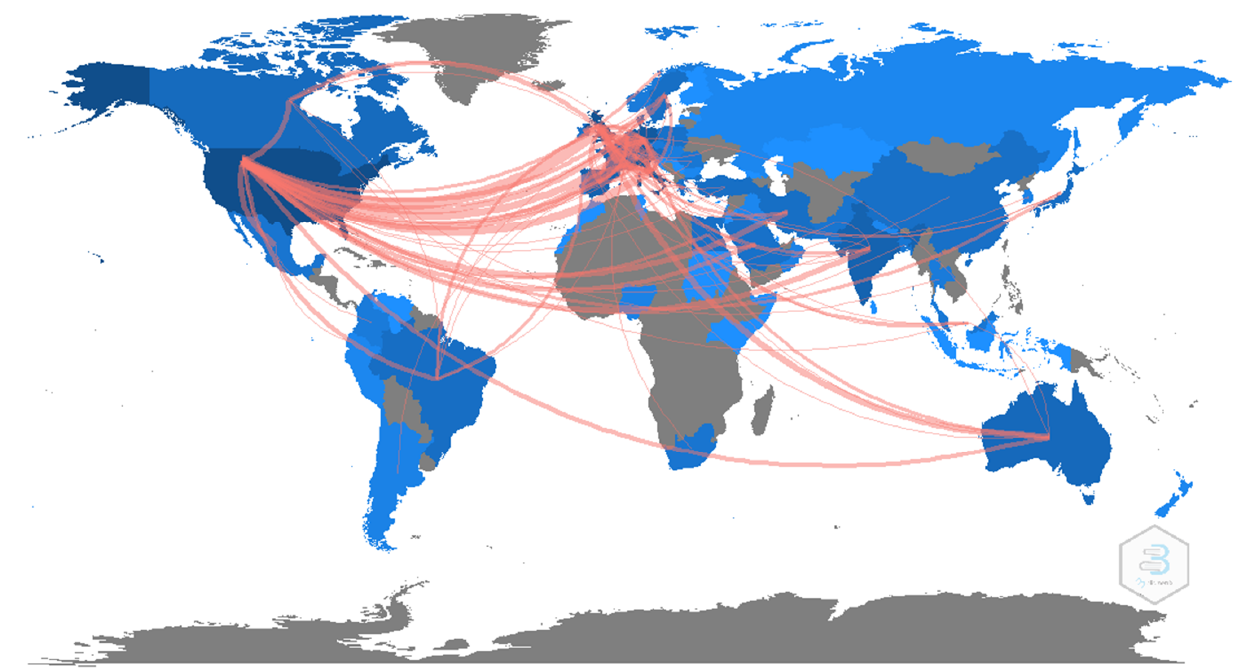
Figure 3. International research collaboration map in original articles on long COVID. Table 2. The top 10 most active